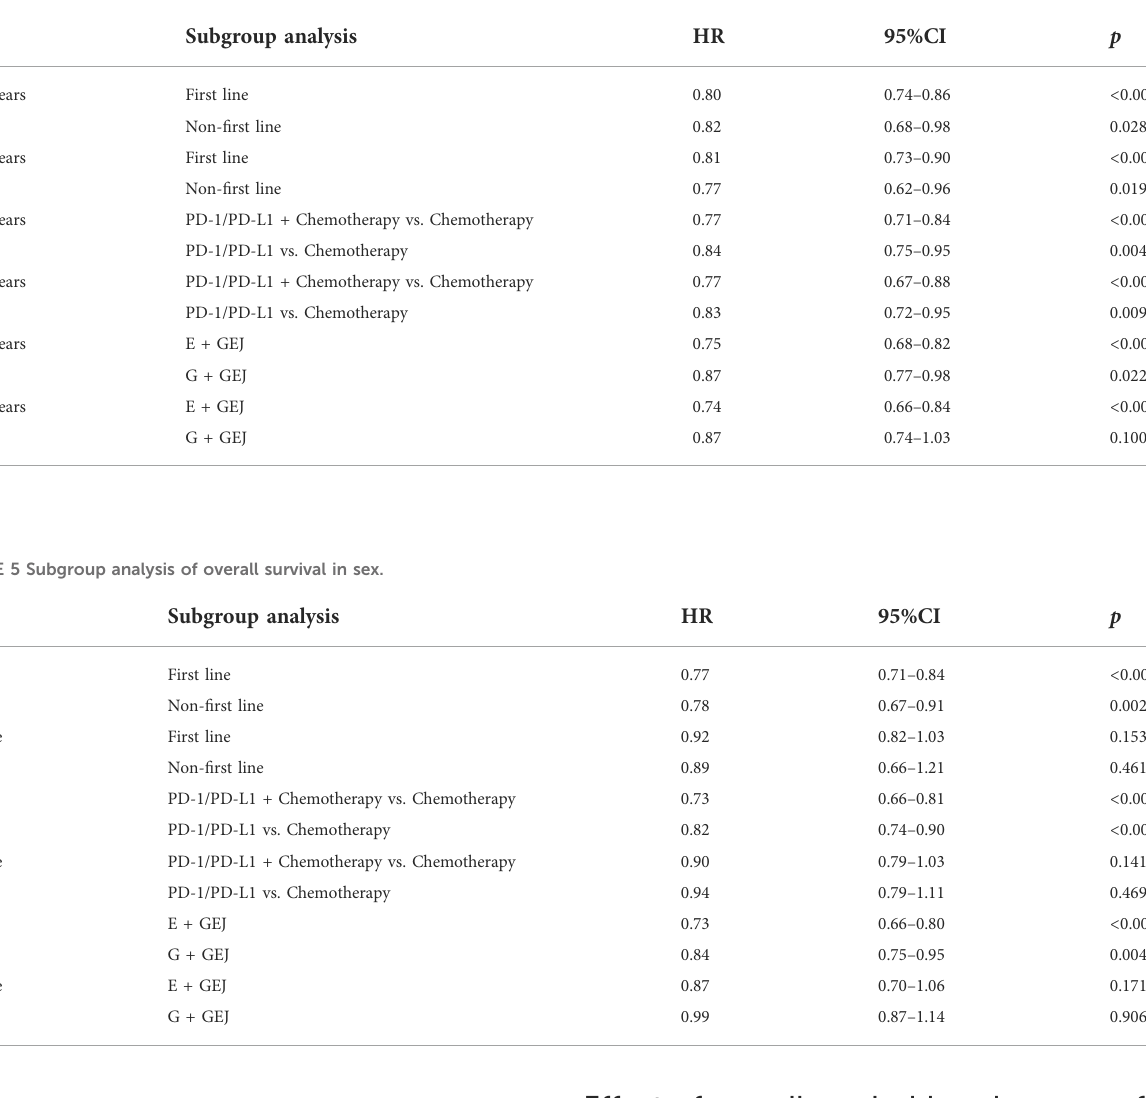
TABLE 4 Subgroup analysis of overall survival in age.